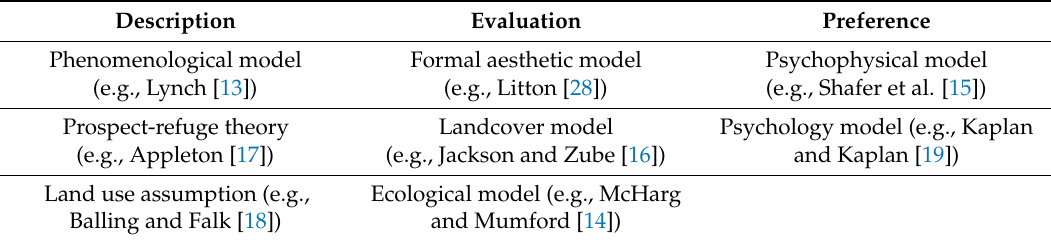
Table 3. Classification of the scenic beauty estimation method methodological